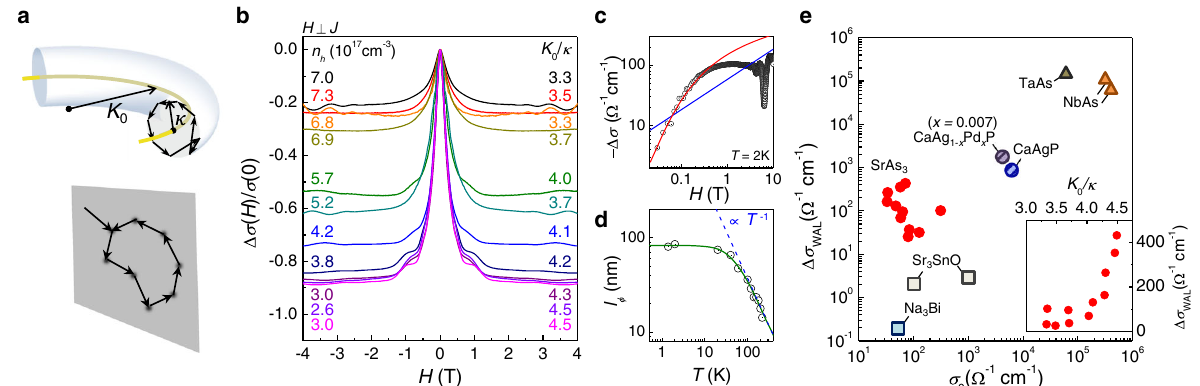
Fig. 4 | Weak antilocalization of nodal-line fermions in SrAs 3 . a Back-scattering processes of nodal-line fermions on the poloidal plane of the torus-shaped Fermi surfaceinthe momentum space (upperpanel).The π Berry fl ux (yellow line) along the nodal-loop leads to weak antilocalization (WAL). The corresponding diffusion of nodal-fermions in the real space is two-dimensional (lower panel), which sig- ni fi cantly enhances the quantum interference effect. b The low- fi eld transverse magnetoconductivity Δ σ ( H )/ σ (0), taken at T =2K and H ⊥ J , from eleven SrAs 3 crystals with different hole carrier densities ( n h ) and the ratio ( K 0 / κ ) between the for different fi eld orientations and extract the phase offset of SdH oscillations ϕ SdH from the interception of the linear fi t (Fig. 3d – g). For both crystals (S1 and S2), ϕ SdH as a function of the polar angle θ on the ( k y , k z ) plane exhibits a clear change from − (0.3 – 0.4) to 0 near θ ~10 ∘ ,